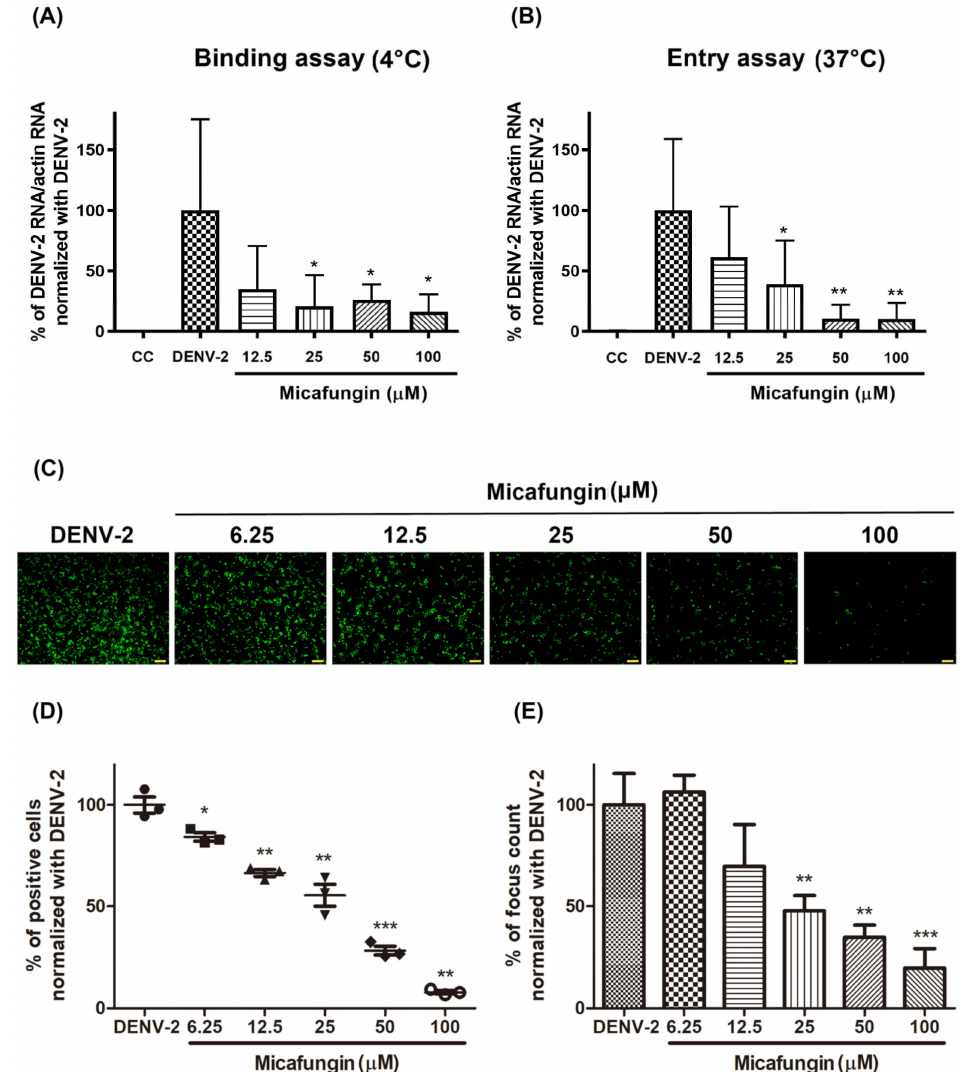
Figure 3. ( A ) Binding assay of micafungin; ( B ) entry assay of micafungin. RT-qPCR was used to quantify the amount of virus binding and entry. Each group was normalized with actin RNA expression and further compared to the DENV-2 group. ( C ) Virucidal assays of micafungin. IFA was used to estimate the infectious ability of DENV-2. Infection rate was determined using ( D ) ImageJ software and ( E ) foci counting. Data was normalized with the DENV-2 group to obtain the percentage of infection. All data were obtained from at least three independent experiments, where significance was indicated as follows: * p < 0.05; ** p < 0.01; *** p < 0.001. Scale bar: 100 µ